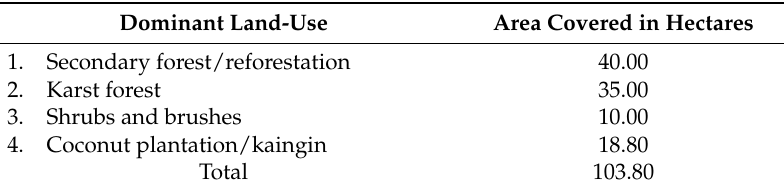
Table 1. Present landuse of the Torrijos Watershed Forest